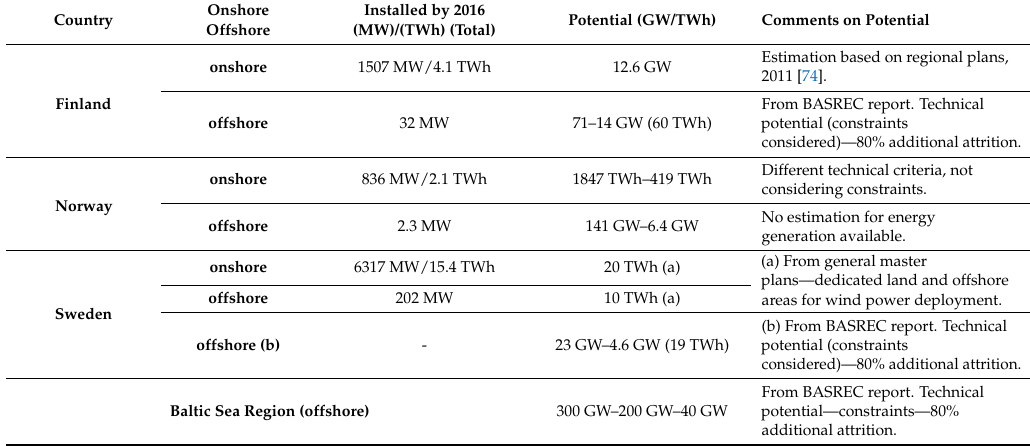
Table 6. Wind power—installed capacity and generation in 2016, national potential wind power deployment ranges on– and offshore. Country Onshore Offshore Installed by 2016 (MW)/(TWh) (Total) Potential (GW/TWh) Comments on Potential